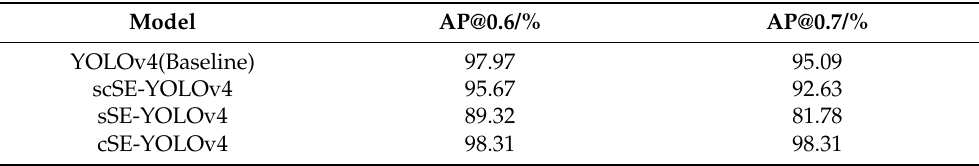
Table 1. The performance evaluation of the three variants embedded in different positions of the network on the test